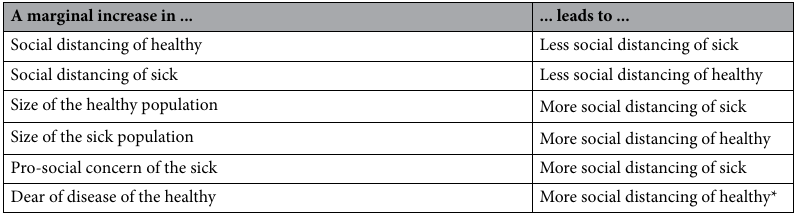
! Contrary to imitation,